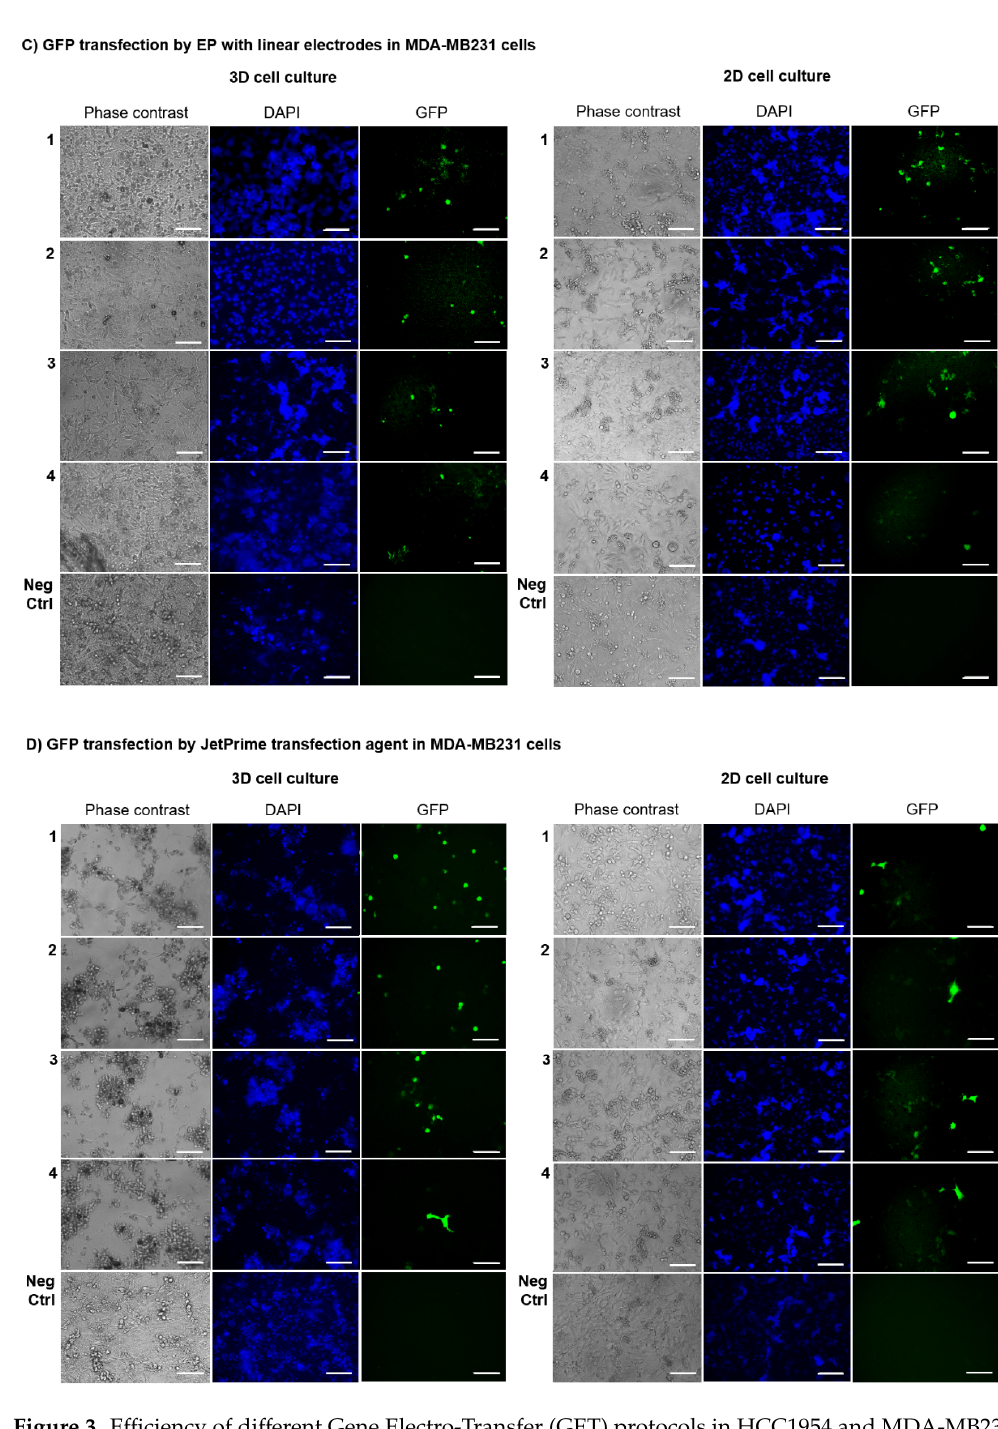
Figure 3. Efficiency of different Gene Electro-Transfer (GET) protocols in HCC1954 and MDA-MB231 cells according to the modality of cell culture (3D versus 2D). Cells were transfected with Electroporation (EP) employing linear electrodes or JetPrime ® transfection agent. Representative fluorescence images of HCC1954 ( A,B ) and MDA-MB231 ( C,D ) 3D and 2D cell culture transfected with green fluorescent protein (GFP) by EP with linear electrodes ( A,C ) and by JetPrime ® transfection agent ( B,D ). Representative micrographs of cells in bright field and using 4′,6-Diamidino-2-Phenylindole (DAPI) and GFP filters. Micrographs are representative of two separate blind experiments with similar outcomes. Not transfected cells are the Negative Control (Neg Ctrl). Observation at three days post-transfection. Magnification 20 × . Scale bars, 100 µ